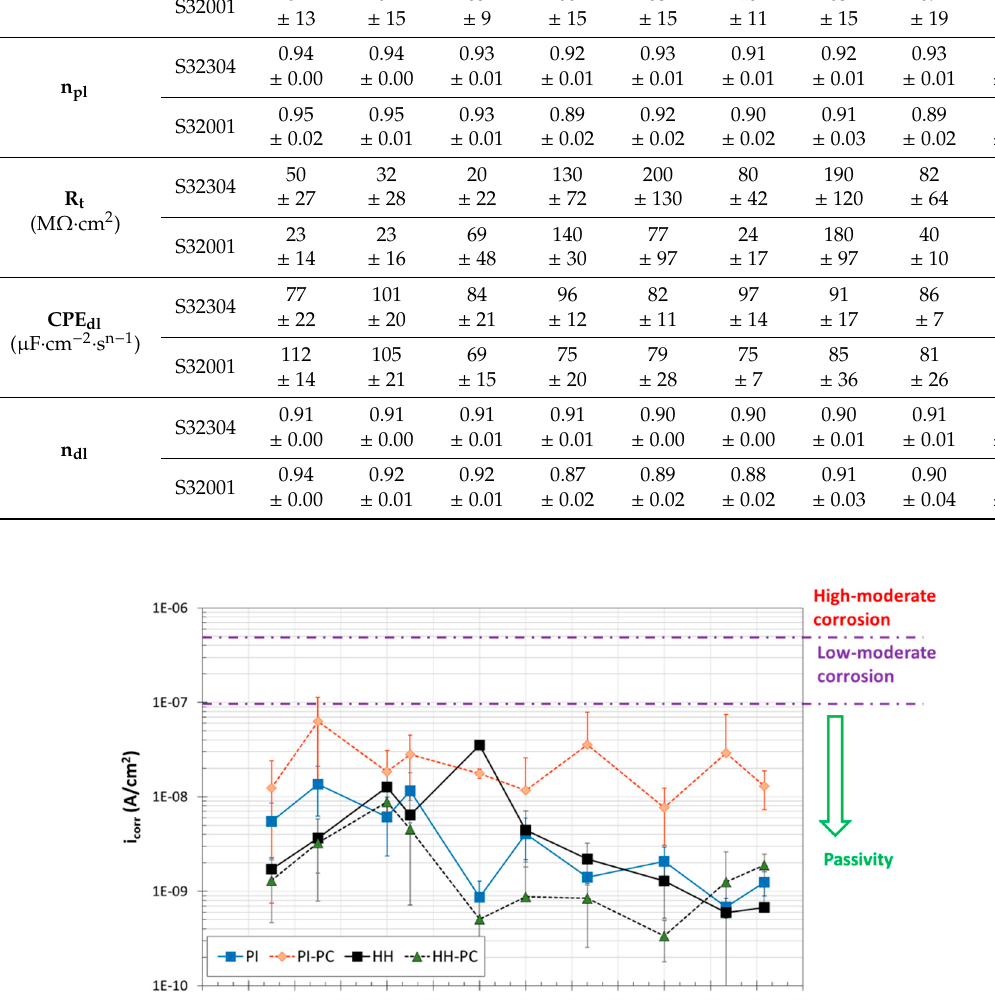
Figure 8. Corrosion rate (i corr ) values calculated from EIS experiments for S32001 steel under different testing conditions. The anodic polarizations carried out at variable, very low rate in all the samples after the exposure allowed us to obtain the results shown in Figures 9 and 10. Although carried out until high anodic polarizations, these studies were always performed in the region of water stability. None of the samples of both studied lean duplex—when they were previously exposed to HH and HH-PC